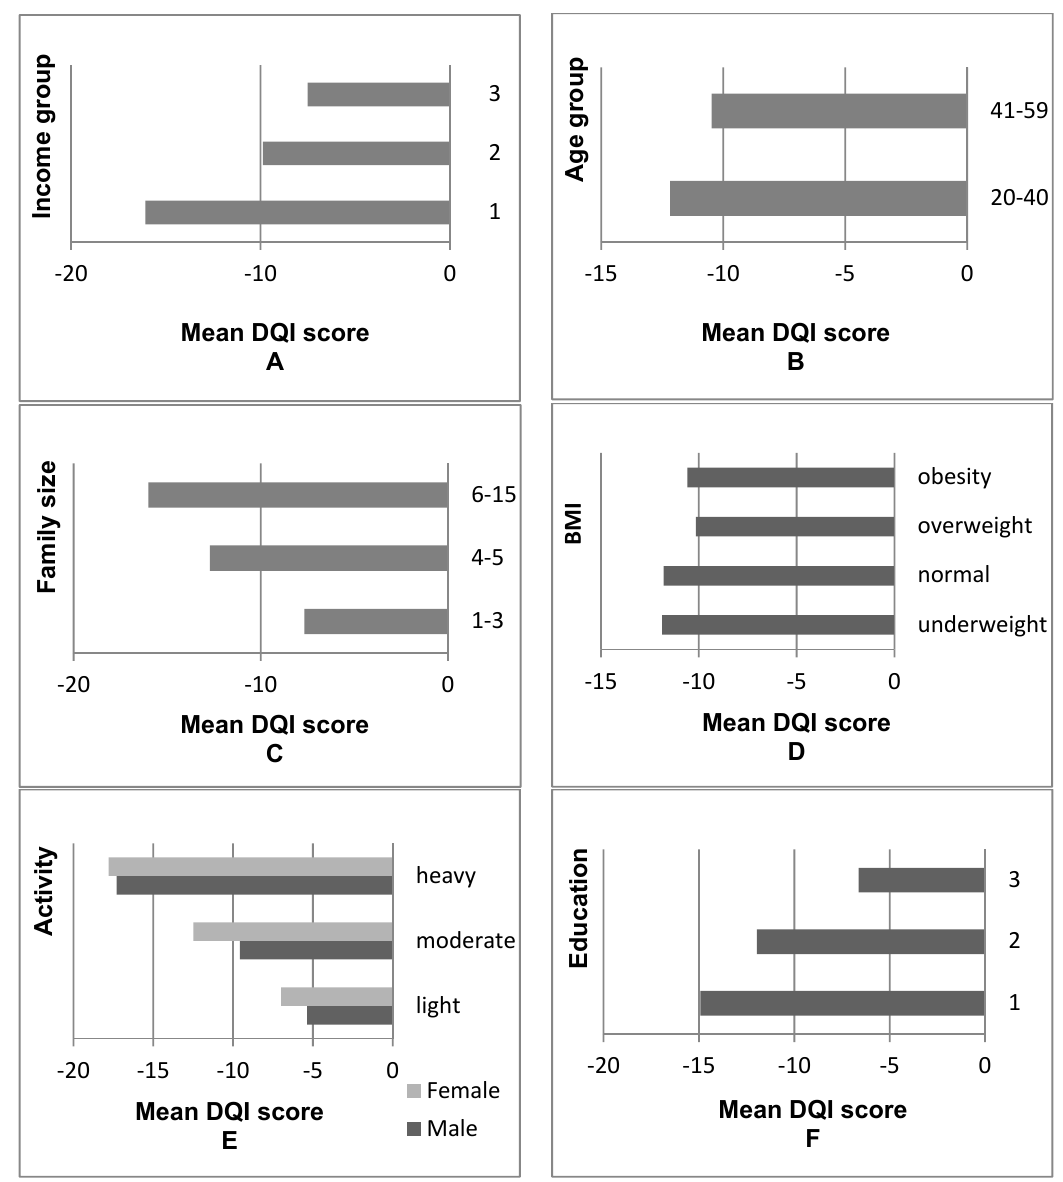
Figure 1. Comparison of DQI values across different groups. ( A ) 1: the poorest group; 2: middle income group; 3: the richest group; ( B ) Young adult: 20–40 years old, old adult: 41–59 years old; ( C ) Number of individuals in the family; ( D ) Underweight: Body Mass Index (BMI) < 18.5 kg · m − 2 ; normal: 18.5